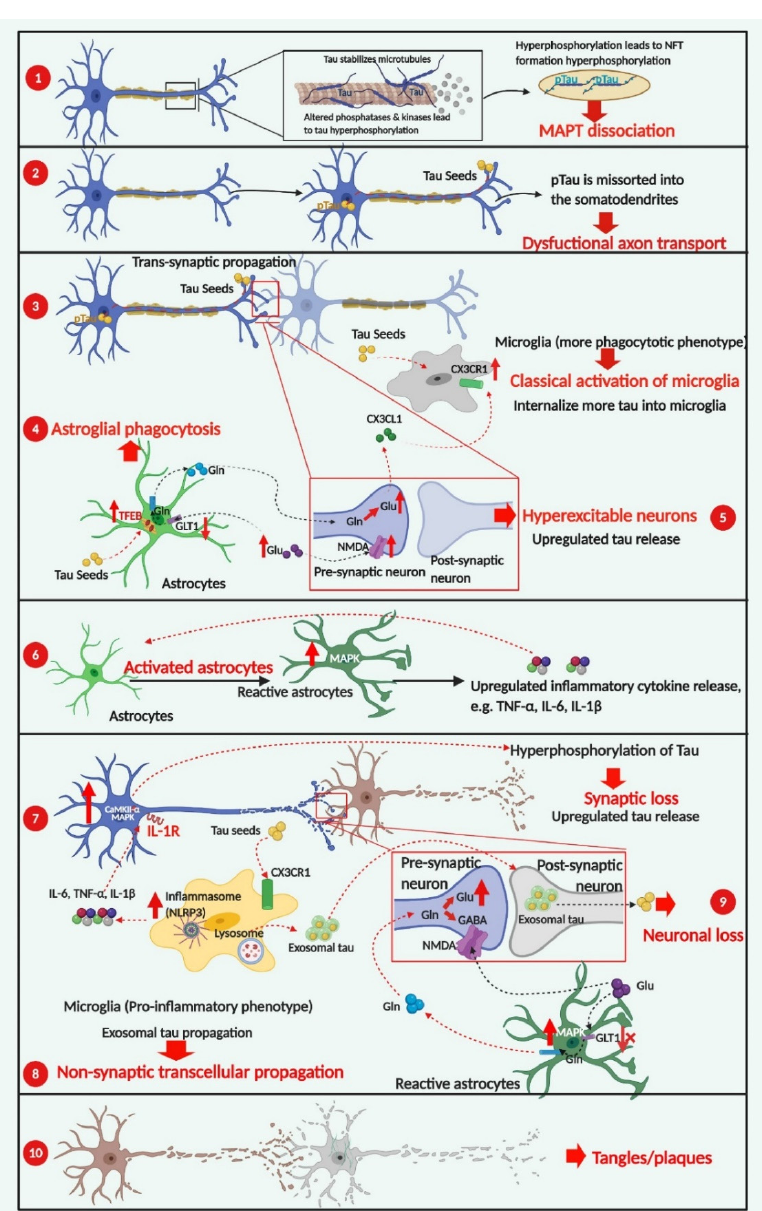
Figure 4. Cellular contributors to tau-dependent degeneration. The development of tau-related pathogenesis has characteristic stages, starting from the formation of tau species consisting of phosphorylated tau dissociated from microtubules (cid:192) . Abbreviation: pTau, phosphorylated tau. Hyperphosphorylation of tau incorrectly sorts tau into the somatodendritic compartment, which is linked to dysfunctional axonal transport (cid:193) , one of the earliest pathological features of tauopathies. Glial cells adapt a more neuroprotective phenotype with microglia classically activated (cid:194) and as- trocytes actively phagocytosing tau species (cid:195) . As disease progresses, astrocytes transform into a loss-of-function phenotype via lower-level expression of astrocyte-specific transporters, leading to neuronal excitotoxicity and upregulated tau release. Additionally, alternatively activated microglia in a pro-inflammatory phenotype are necessary and sufficient to induce reactive astrocytes with the capability of releasing neuroinflammatory cytokines (cid:197) . At the later stages of disease progression, the microglial-exosomal pathway acts as the essential tau propagation pathway (cid:199) as an alternative to transsynaptic transduction, due to extensive synaptic degeneration and neuronal death (cid:200) . The forma- tion of neuronal and glial tau plaques is the most important hallmark of tauopathies (cid:201) . Red arrows indicate pathological consequences of change. Created in